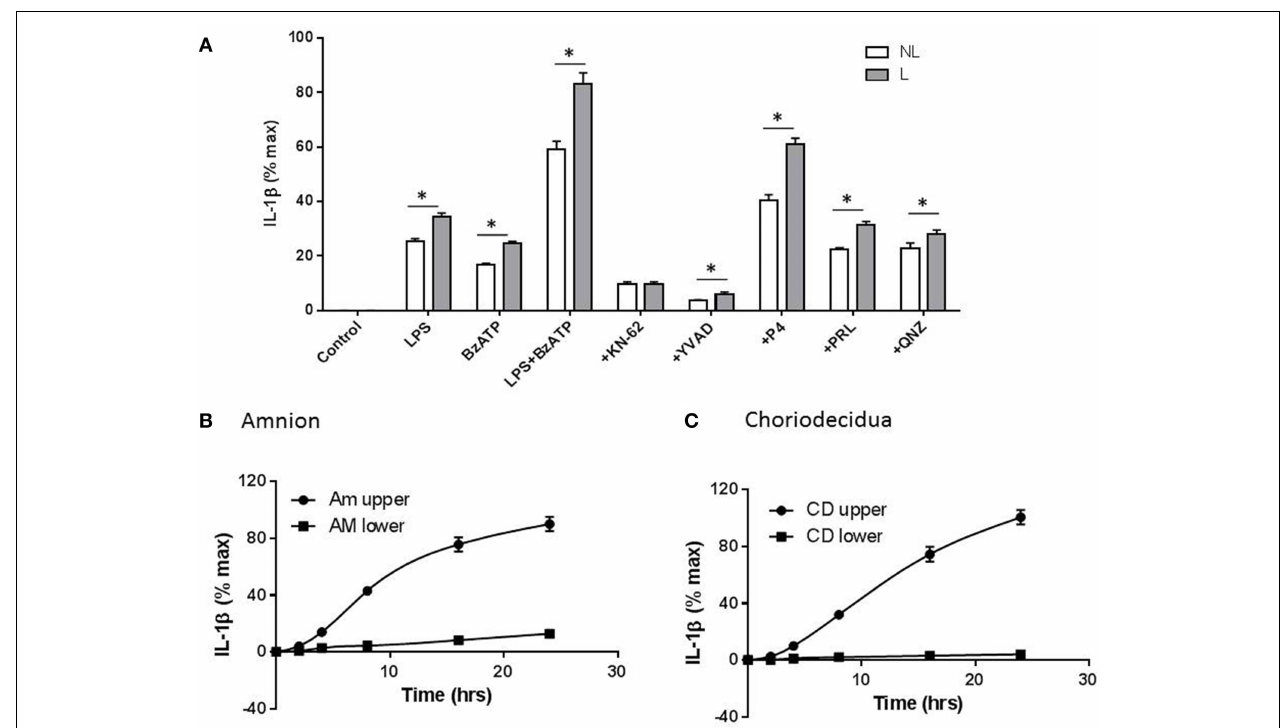
sides (upper) and (lower) of the transwell, amnion produced IL-1 β only in the upper compartment (C) when choriodecidua was uppermost and upper and lower chambers tested for IL-1 β production, higher levels of the cytokine were produced from the upper chamber and were higher than those produced when amnion was uppermost ( n = 6 ; P < 0 . 05 ). IL-1 β amounts are expressed per/cm 2 . * P < 0.05 comparing each treatment between NL and L